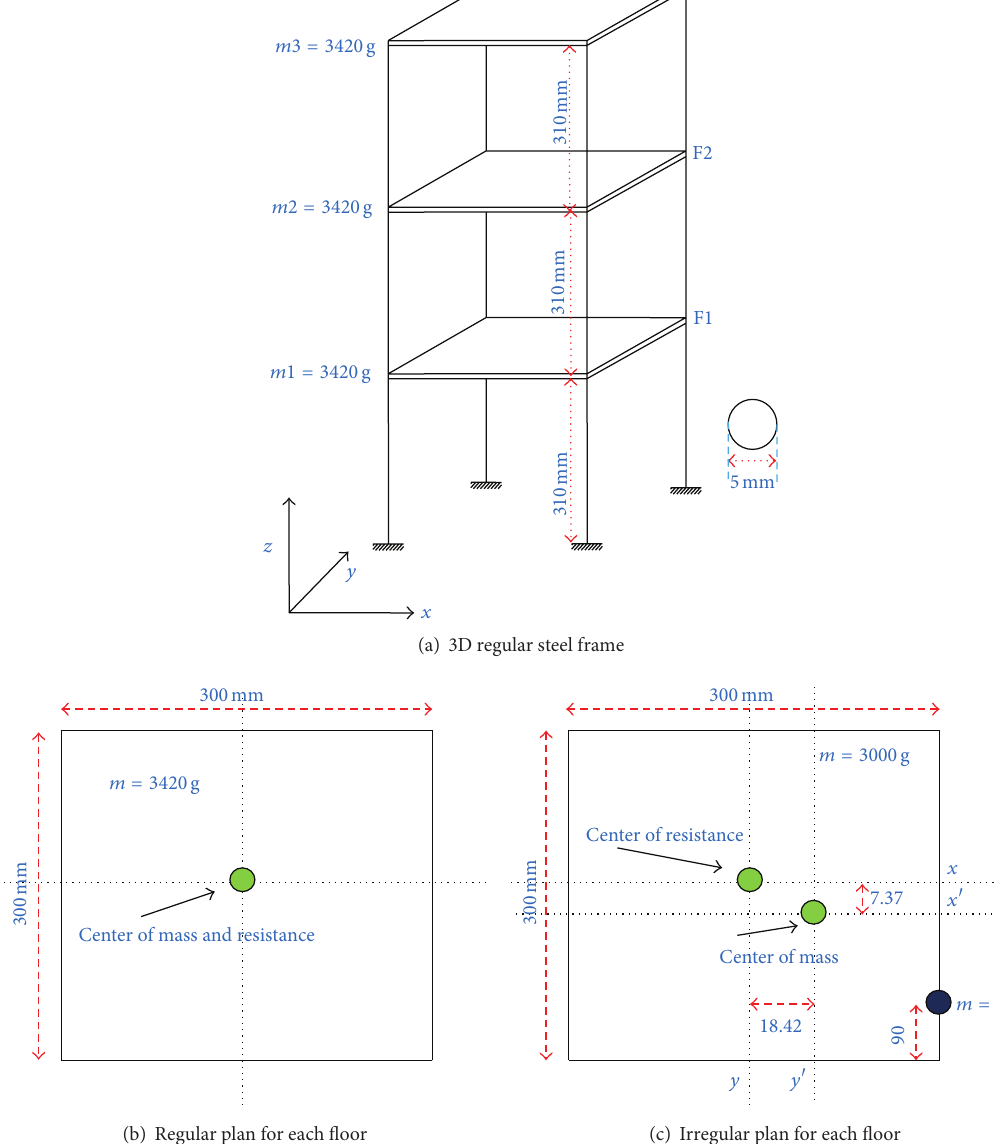
Figure 1: Simulated regular and irregular 3D three-story resisting steel frame building structure ( unscale dimensions